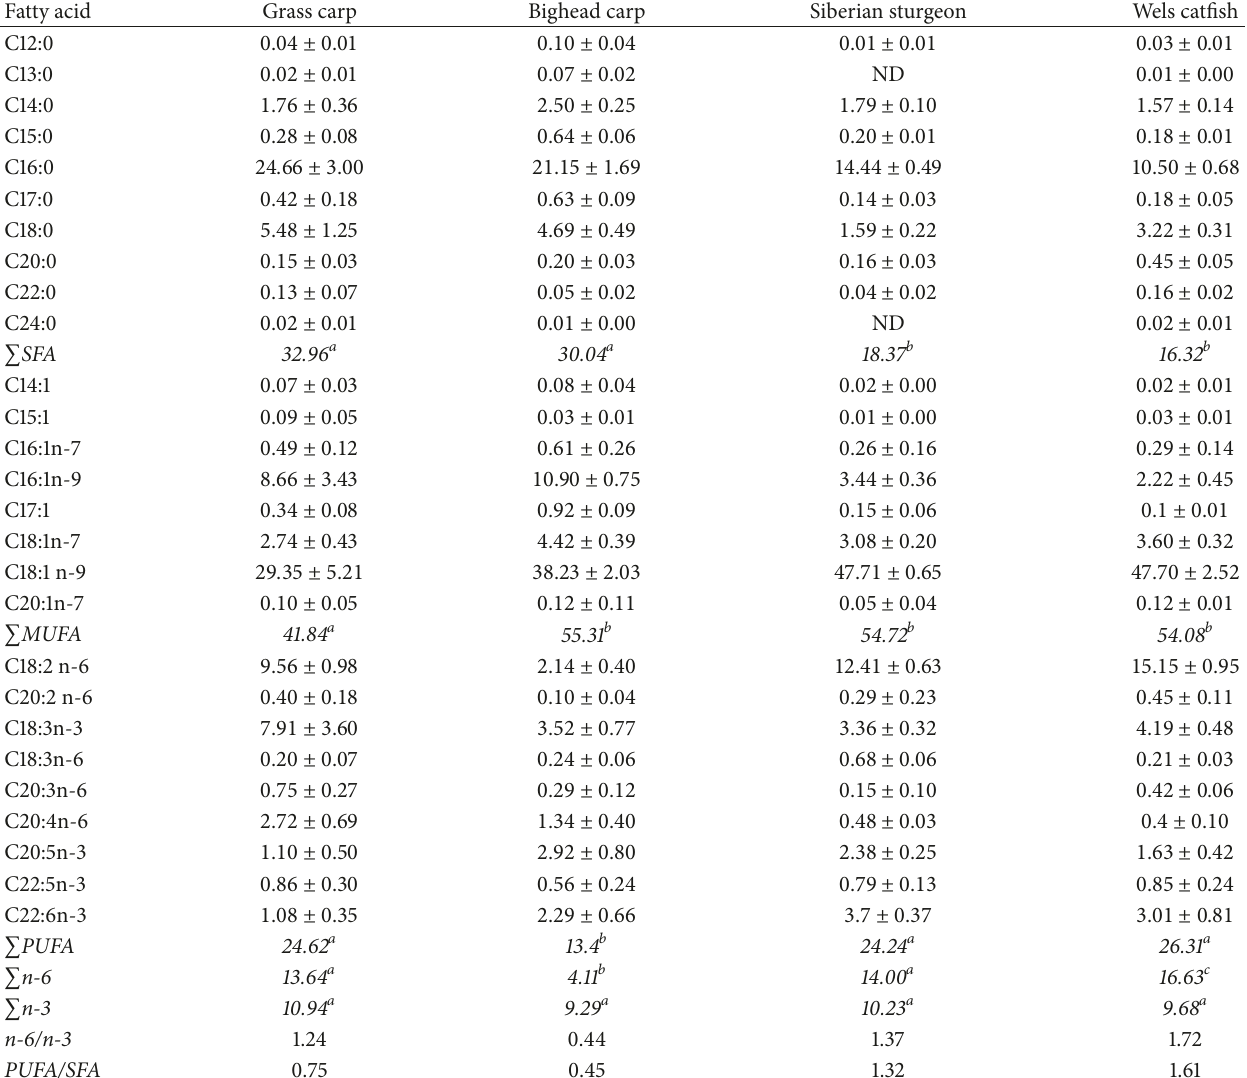
Table 1: Fatty acid composition (%) of the fat extracted from analyzed fish (mean value ±